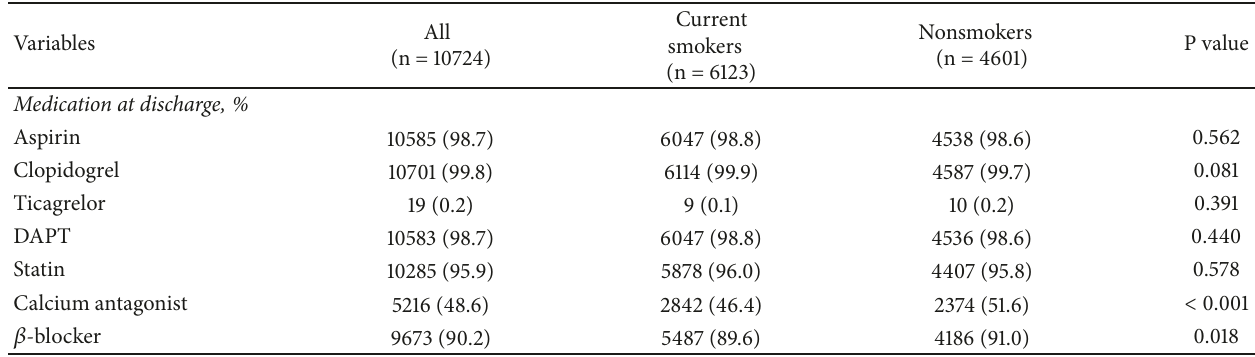
Table 2: 2-year outcomes.